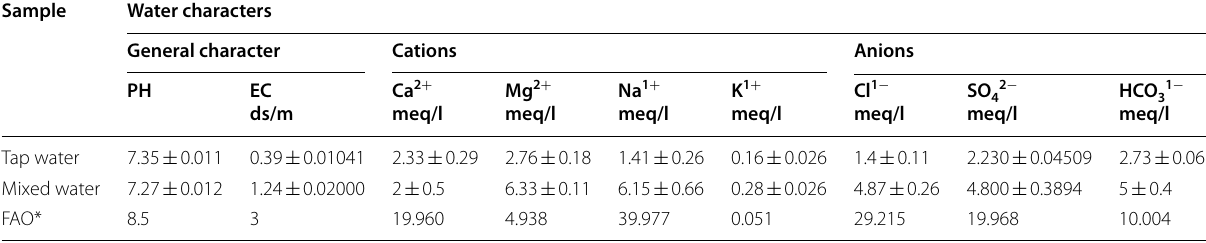
Table 1 Water analysis of PH, EC, cations and anions in mixed wastewater and tap water (control) Sample